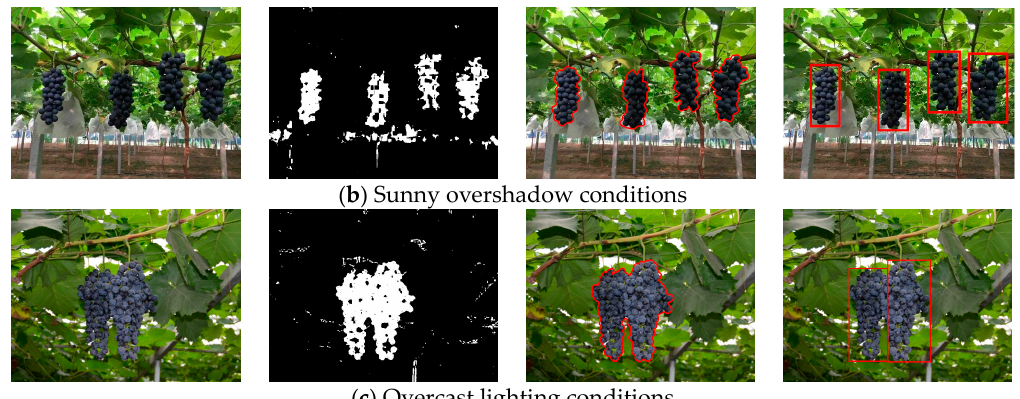
Figure 7. The detection results of the grape clusters from the images captured under three different lighting conditions by the developed method. ( a ) Image captured under sunny frontlight conditions; ( b ) Image captured under sunny overshadow conditions; ( c ) Image captured under overcast lighting conditions.